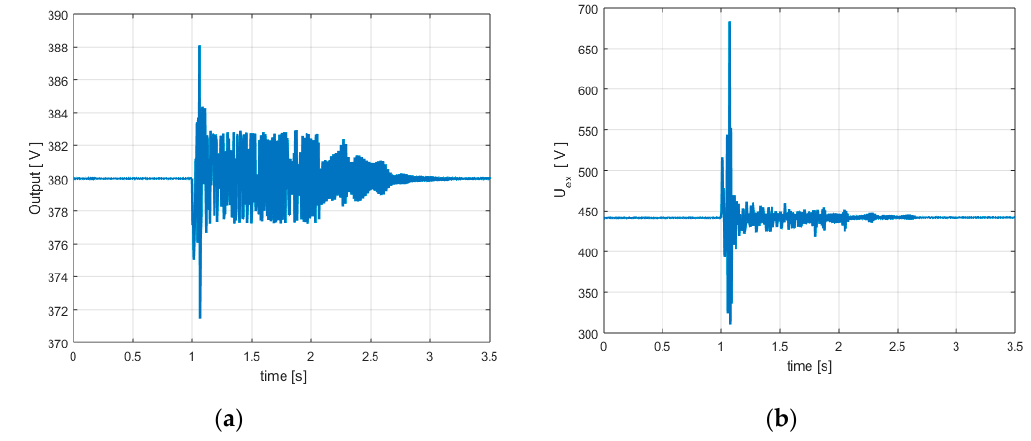
Figure 8. Mechanical torque variation—3rd order model: (a) Terminal voltage (controlled output); (b) Excitation voltage (controller output).